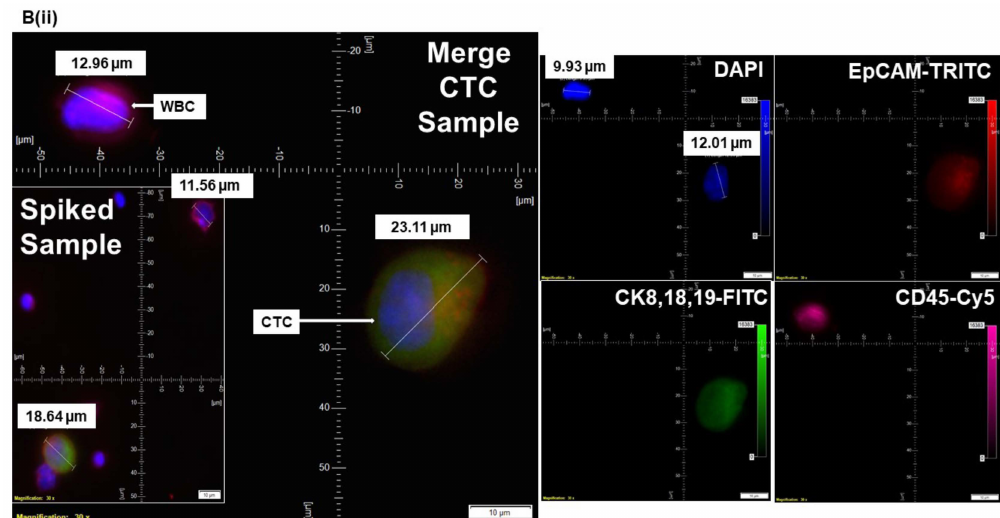
Figure 3. Standardization and validation of CTC by ICC × 2 in reference to spiked IF × 3 in endometrial and ovarian cancers: CTCs were captured from blood samples from patients with endometrial ( A ) and ovarian ( B ) tumors and enumerated using ICC × 2 ( Ai , Bi ) in reference to IF × 3 ( Aii , Bii ). Blood samples were spiked (Spiked samples) with titrating numbers (250 cells/100 cells) of NCI-H441 cells separately for both ICC × 2 and IF × 3. For IF × 3, pictures were taken at 60 × oil objective of an Olympus IX71 Microscope with DAPI/FITC/TRITC/CY5 filter sets. For ICC × 2, pictures were taken at 40 × objective of an Olympus BX43 Microscope. The magnification, scale bar, and digital reticle are represented for each photomicrograph. Fluorescence images from DAPI, FITC, TRITC, and Cy5 channels were separated as pictures with a color bar. The fluorescence-photomicrographs presented the diameters ( µ m) of CTC and a representative WBC and their respective DAPI stained nucleus. The immunocytochemistry-photomicrographs are presented with a scale bar, magnification information, digital reticule, as well as the diameters ( µ m) of CTC and a representative